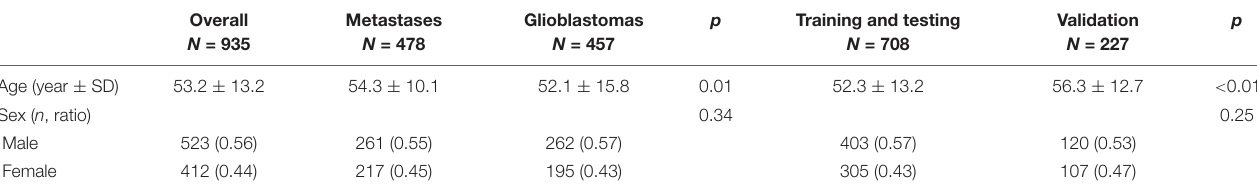
TABLE 1 | Age and sex distribution.